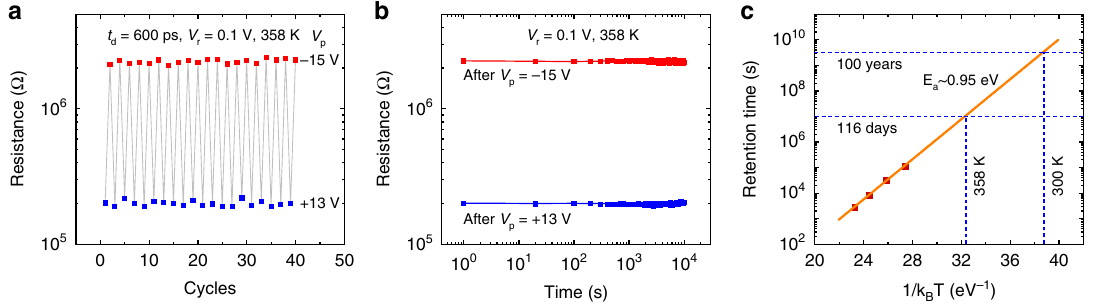
Fig. 6 Temperature endurance of the FTJs. a Resistance switching with t d = 600 ps at 358 K. b Retention characteristic of the corresponding resistance states in a . c retention time versus 1/ k B T . The points are the experimental data at 423, 448, 473 and 498 K, and the solid line is the fi tting result by Arrhenius relation.